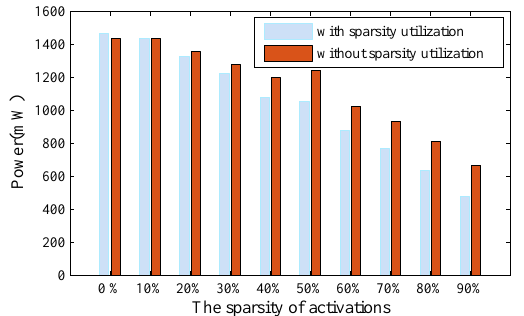
Figure 16. Power consumption vs. different levels of the sparsity in the